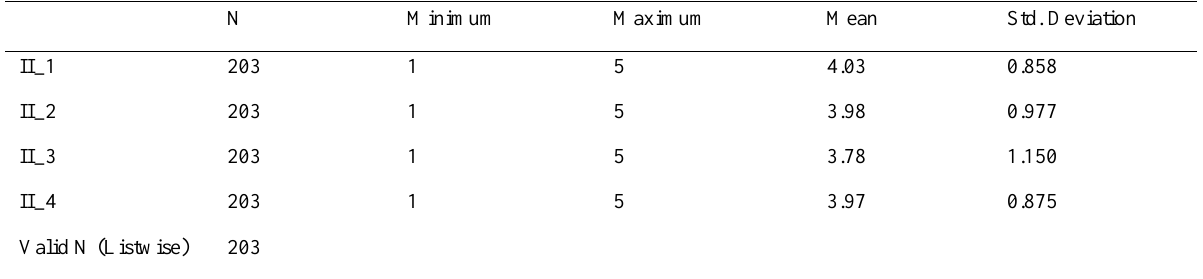
Table 5: Idealized Influence